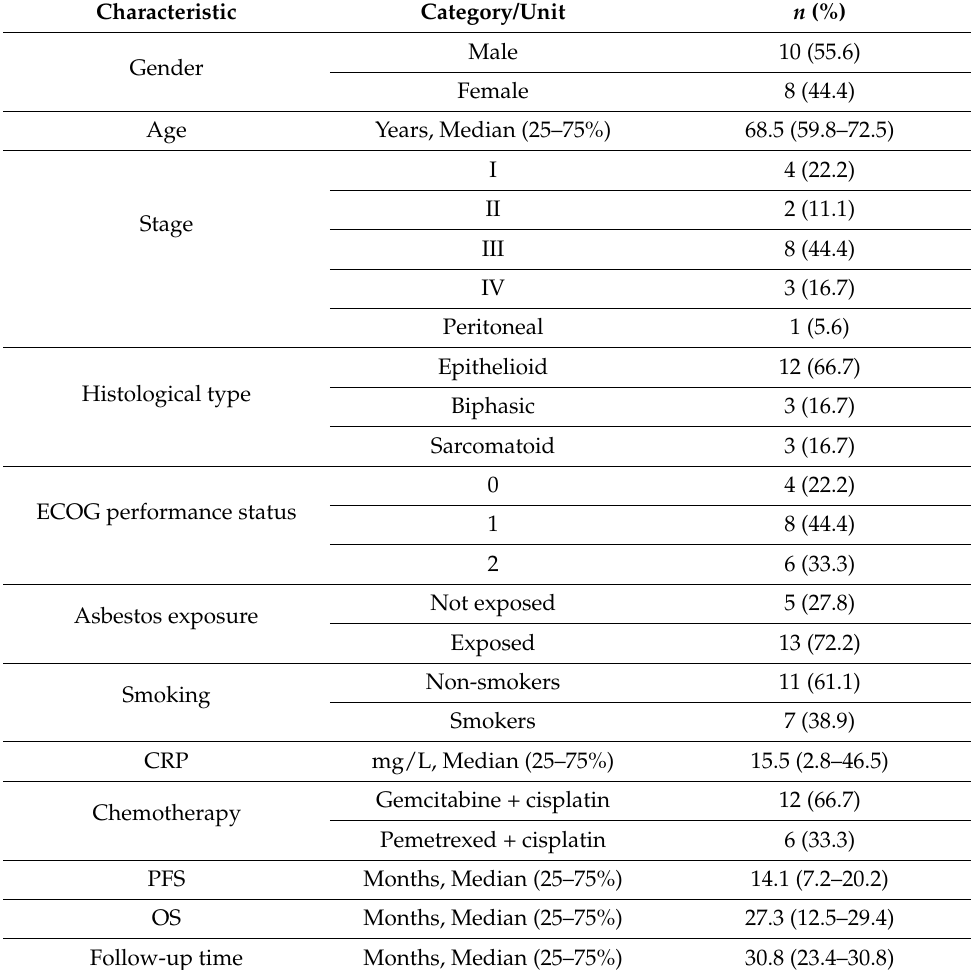
Table 1. Clinical characteristics of malignant mesothelioma patients ( n = 18).